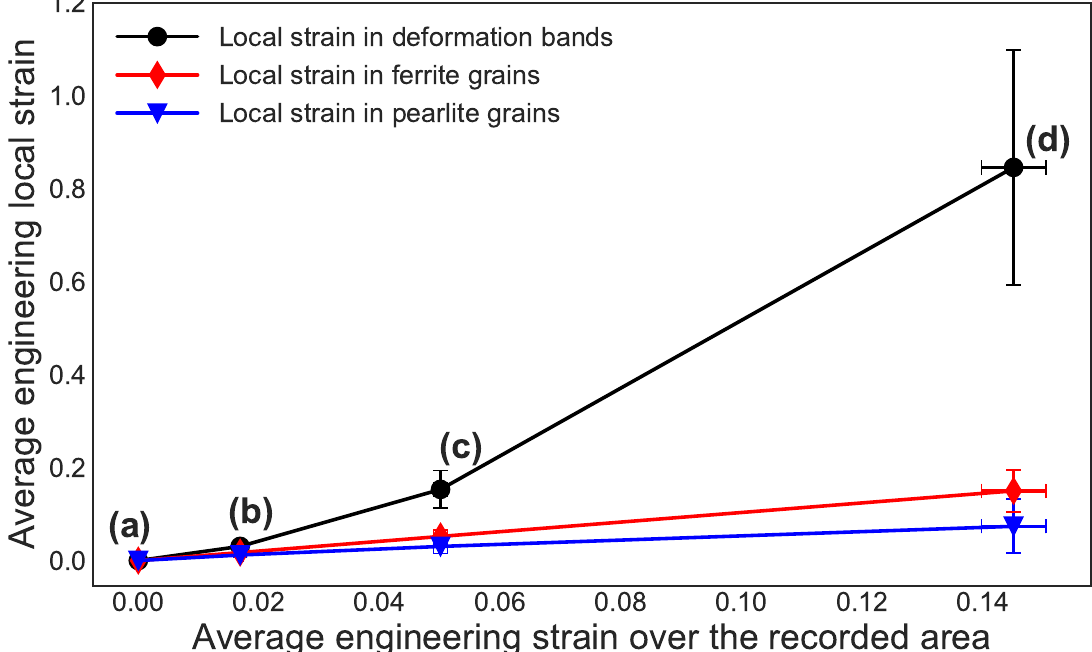
Figure 14. Local strain evolution in pearlite and ferrite grains and the localized deformation bands marked in Figure 12d. The grains selected for the local strain measurements are indicated with blue squares and red diamonds in Figure 15a for pearlite and ferrite, respectively. The average engineering strain over the recorded area are measured using the vectors in Figure 15b.